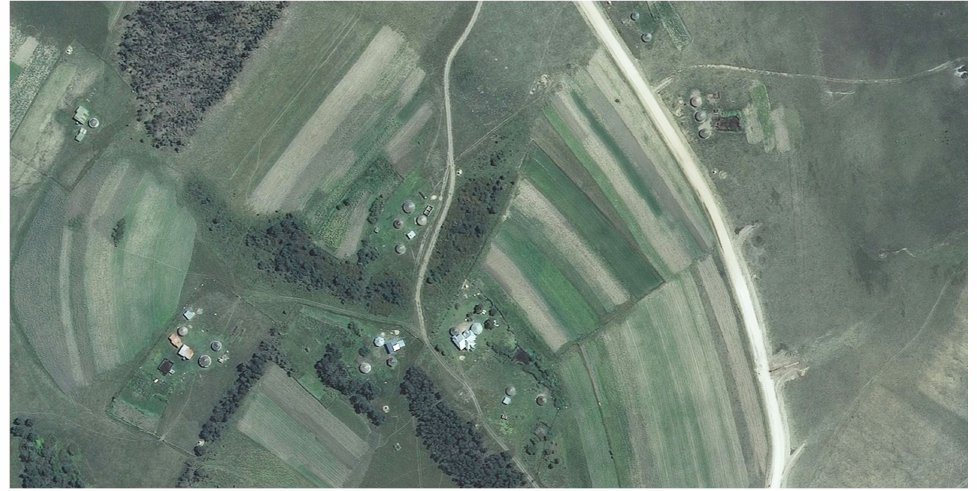
Figure 10. Extract from 2015 rectified imagery [12] (Ref: 3130 AA 11), showing small-scale farm- ing in a rural area known as Mahana, on communal land in the Eastern Cape Province, at scale: 1:5000